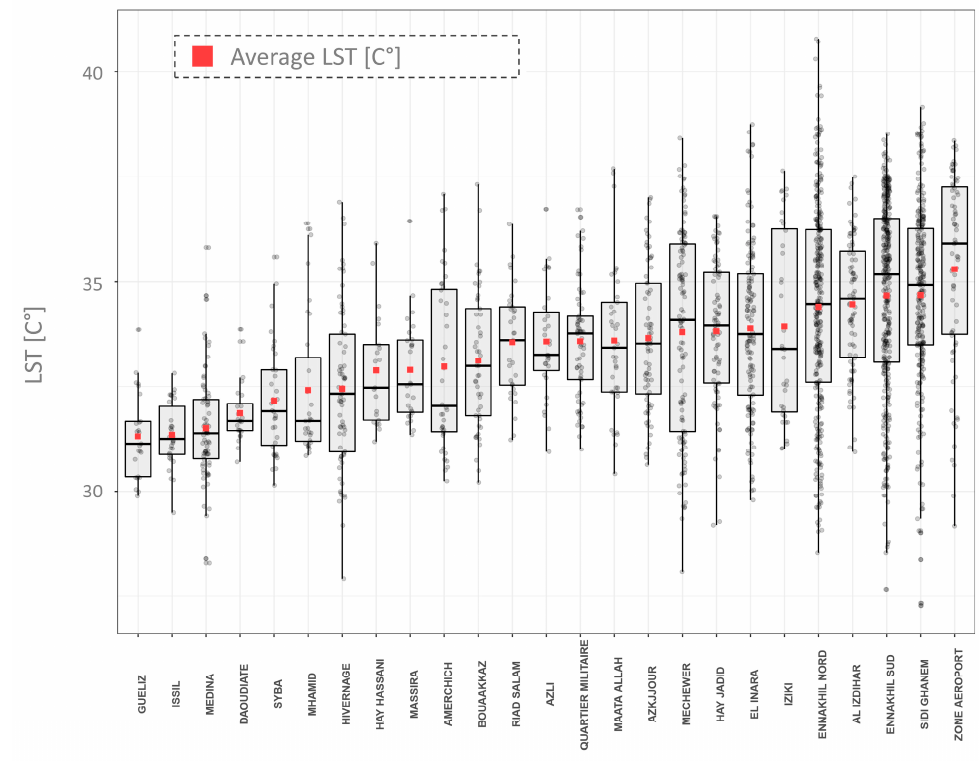
Figure 5. Average temperature by district.